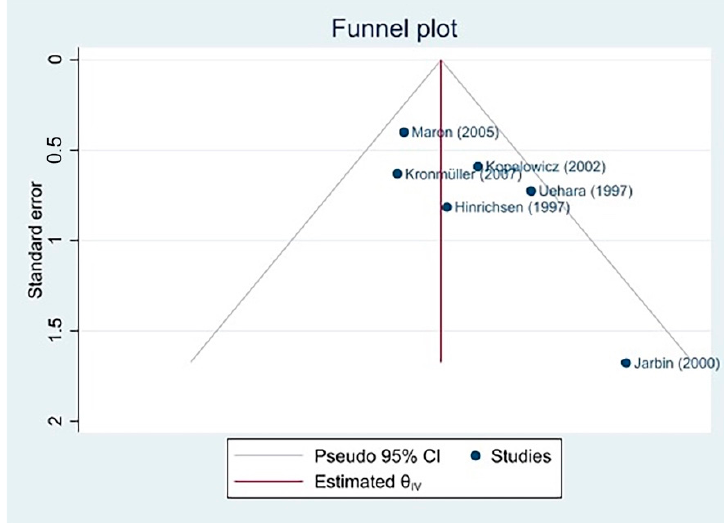
Figure 6. Funnel plot of the meta ‐ analysis conducted with all six studies